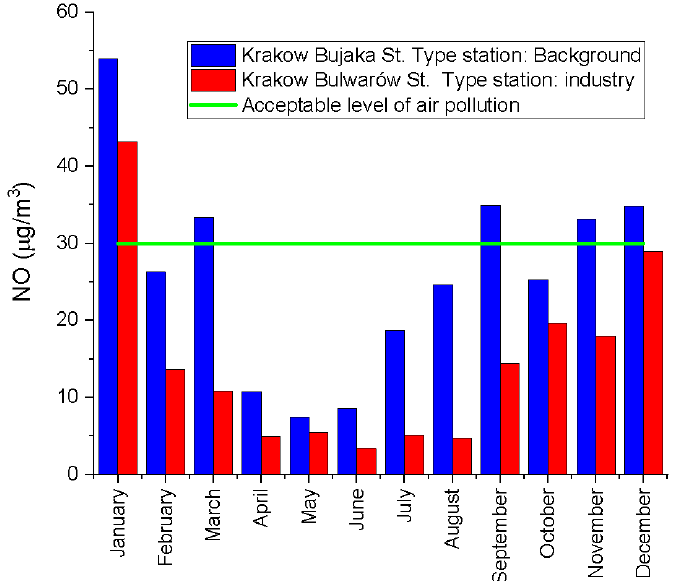
Figure 11. Average NO concentration in individual months of 2020.